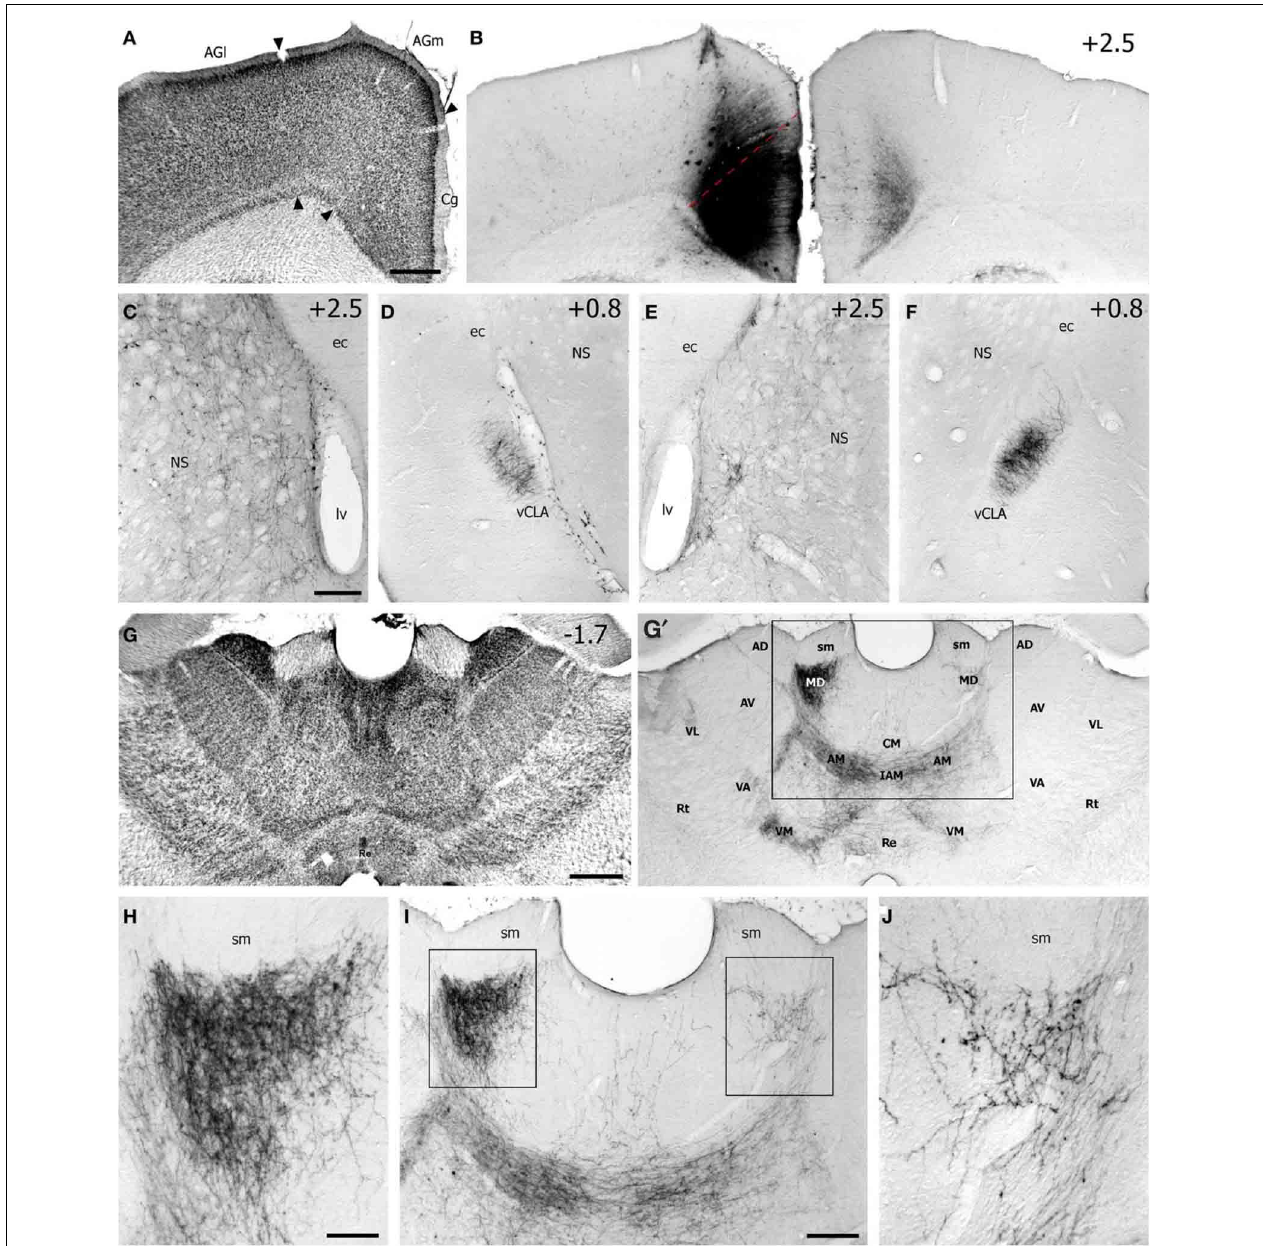
FIGURE 1 | Case TI-16 demonstrates that the FEF projects to claustrum and other forebrain regions. (A) Nissl-stained section through the lateral agranular (AGl), medial agranular (AGm), and cingulate (Cg) cortices. (B) Deposit of biotinylated dextran amine (BDA) at an M1 site in Cg cortex that evoked eye movements and produced labeled terminals in the contralateral Cg cortex. (C–F) The BDA deposit produced labeled terminals in the dorsomedial neostriatum (NS) and ventral claustrum (vCLA) in the left (C,D) and right (E,F) hemispheres. (G) Nissl-stained section of thalamus used to